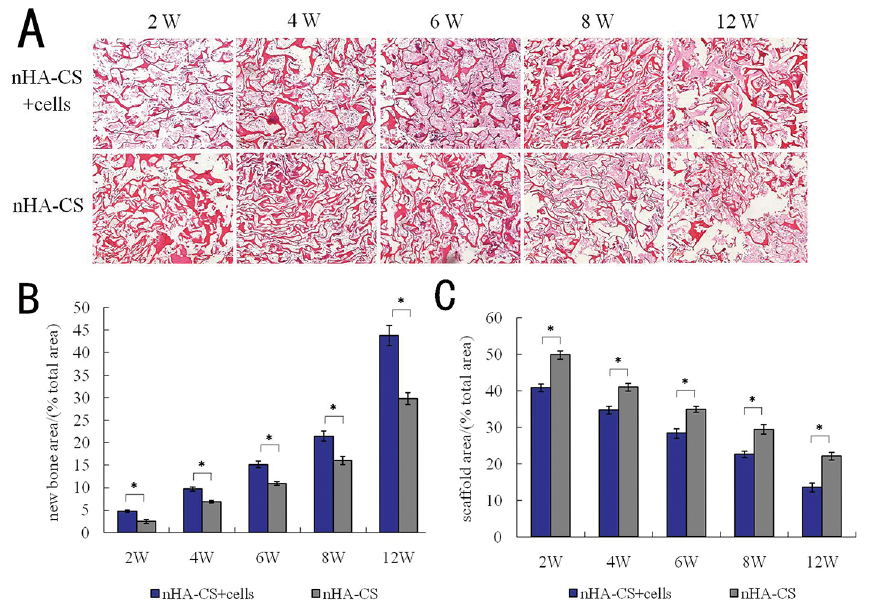
Fig 5. Histological examination of HE staining. (A) Representative HE images of implants from the two groups harvested at different time points (figure magnification 100×). (B) The analysis of the proportions of newly formed bone area indicated that the nHA-CS+cells group gained greater amounts of de novo bone compared with the nHA-CS group ( * P < 0.05). (C) The analysis of the proportions of the scaffold area revealed that the nHA-CS+cells group exhibited significant scaffold degradation than the nHA-CS group ( * P < 0.05).